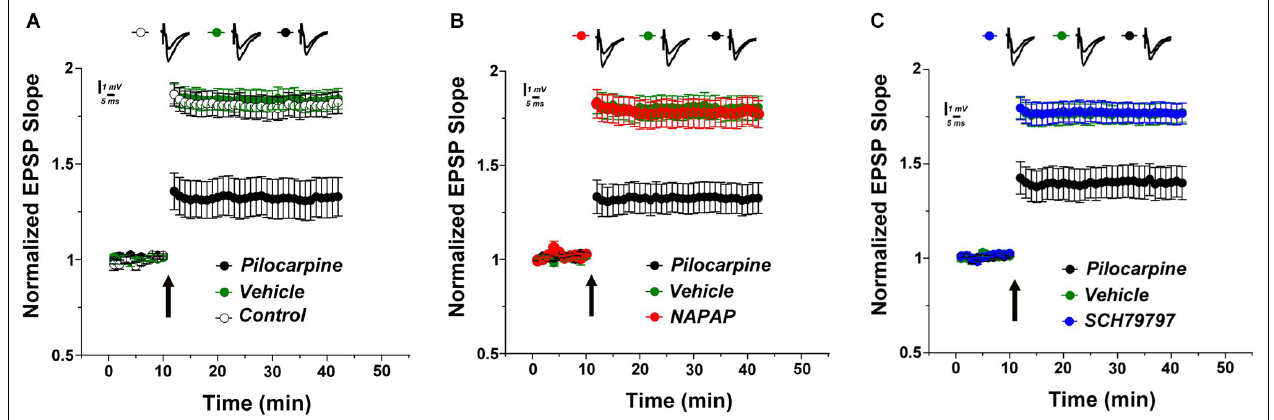
FIGURE 2 | Coagulation and inflammation mRNA expression modification in the hippocampus of animals 24 h after SE induction. (A) PAR1 levels increased significantly in the pilocarpine-only group compared to the SCH79797 PAR1 antagonist group. No significant differences between groups were measured in prothrombin (B) relative expression. Levels of the inflammatory marker TNF- α (C) were elevated following SE induction in the pilocarpine-only group compared to controls (Coagulation and inflammatory markers: control n = 8, pilocarpine n = 7, α -NAPAP n = 8, SCH79797 n = 7). SE, status epilepticus; PAR1, protease-activated receptor; TNF- α , tumor necrosis factor α . * p < 0.05, ** p < 0.01.